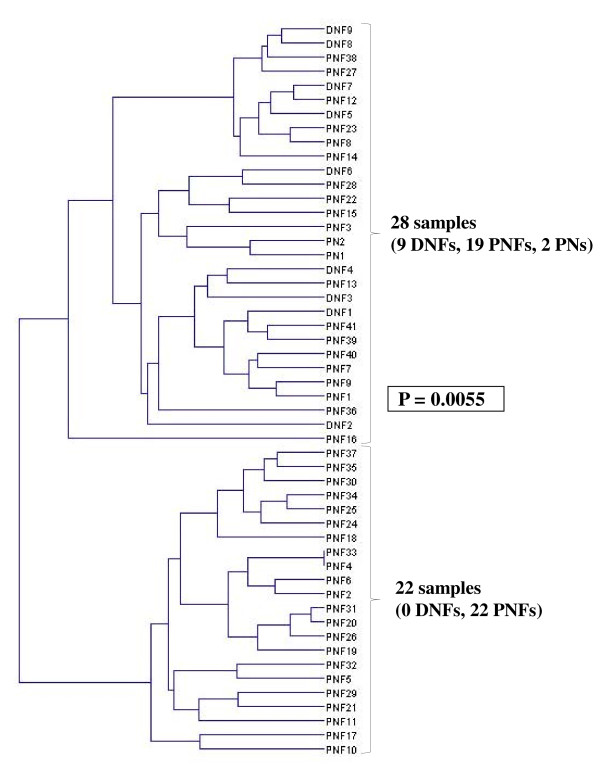
Dendrogram of the nine DNFs, 41 PNFs, and two peripheral nerves (PN1 and PN2) constructed using a supervised hierarchical clustering with UPGMA algorithm according to the expression of the 11 miRNAs significantly deregulated between DNFs and PNFs.